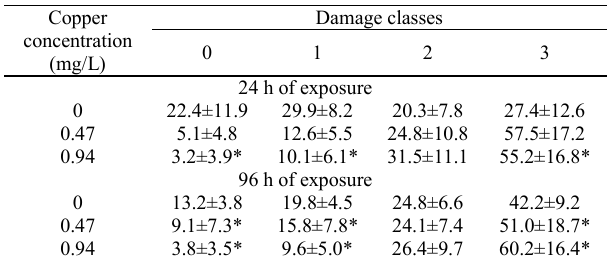
Table 1. Frequency (%) of classes of DNA damage in erythrocytes of the Centropomus paralellus exposed to Cu (0.47 and 0.94 mg/L) for 24 and 96 h. Data are mean ± standard deviation. *Denotes significant different mean values between control and Cu-exposed fish (p<0.05).